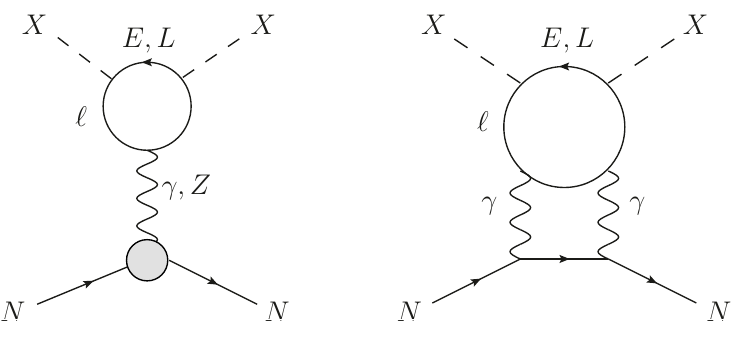
Figure 6 . Example diagrams for DM-nucleon scattering at direct detection: (left) photon and Z penguin contributions for the complex DM; (right) leading 2-loop contribution for the real DM. There are similar penguin contributions in the fermion